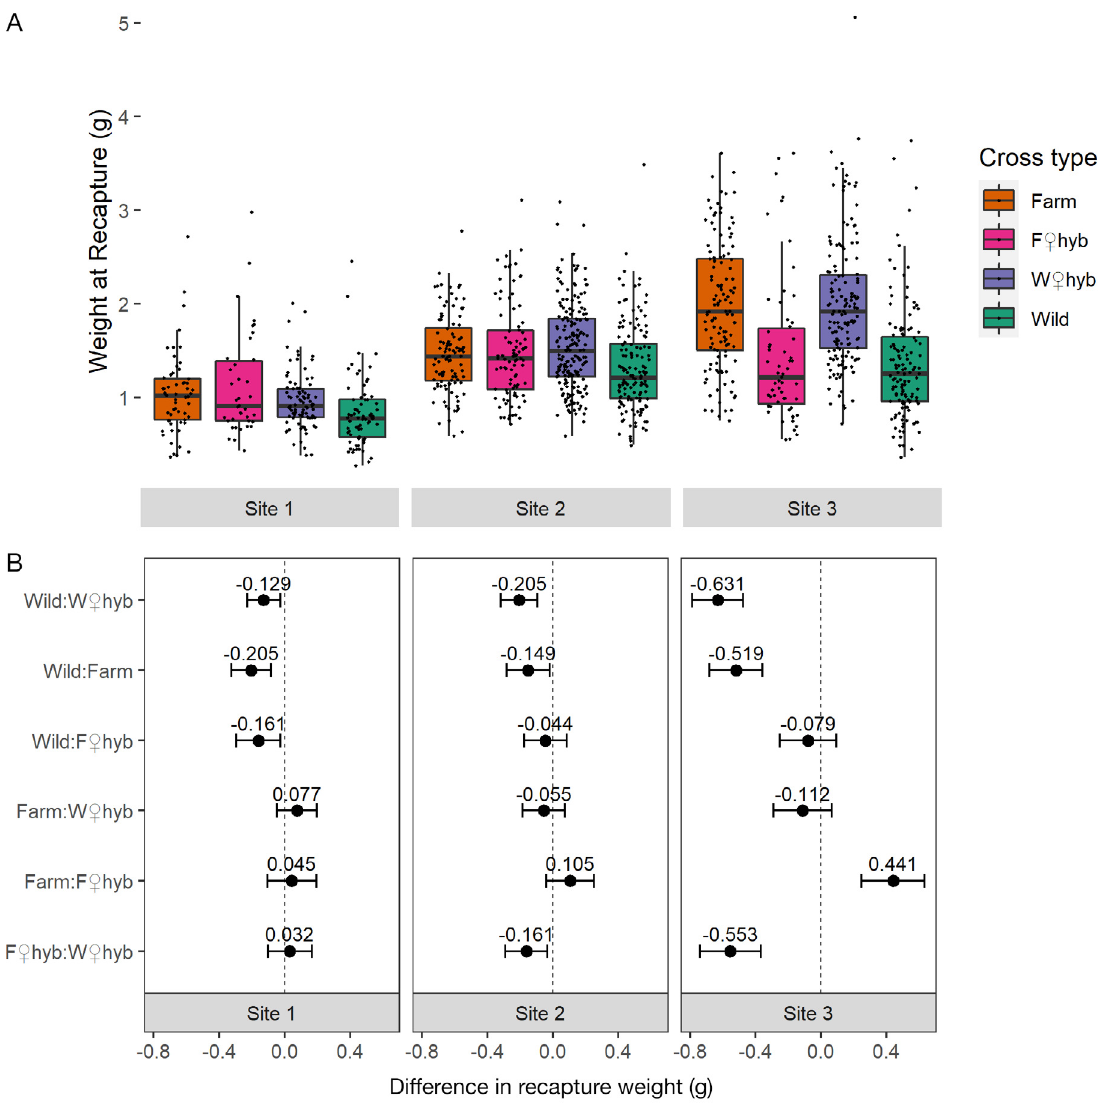
Fig. 5. (A) Weights of each Atlantic salmon at recapture for each cross type × site pairing, and (B) pairwise differences in mean recapture weight for each cross type by site pairing. Boxplot parameters in (A): lines: median values; upper and lower hinges: third and first quartiles (respectively); upper and lower whiskers extend to furthest value no more than 1.5 times the inter- quartile range above and below the upper and lower hinges (respectively). Error bars on pairwise differences in (B) ±2 SE of the difference of distances between least-squares means of overall shape were made between cross types and between = 27.78, LR = 9.26 × 10 15 , p < 0.001) were >100, ( F sites (Table 1), after accounting for centroid size. For 3,727 and these terms were thus selected for a reduced cross type comparisons, distances between means model (all other terms had LRs < 1) (Table S6). LRs were largest for farm vs. wild and smallest for farm vs. for the effects of centroid size, site, and cross type pro- F f hyb; for sites, distances were largest between Sites 1 vided strong evidence for their inclusion in the re- and 2 and smallest between Sites 2 and 3. The largest duced model; however, the size of their effects on cross type differences appeared to be for landmarks shape was small. Centroid size explained 8.9% of the associated with body depth, with wild having smaller variation in the data, site explained 6.3%, and cross depths than other cross types; however, once again it type explained 8.6% (Table S6). Pairwise comparisons is important to note that overall differences were small.